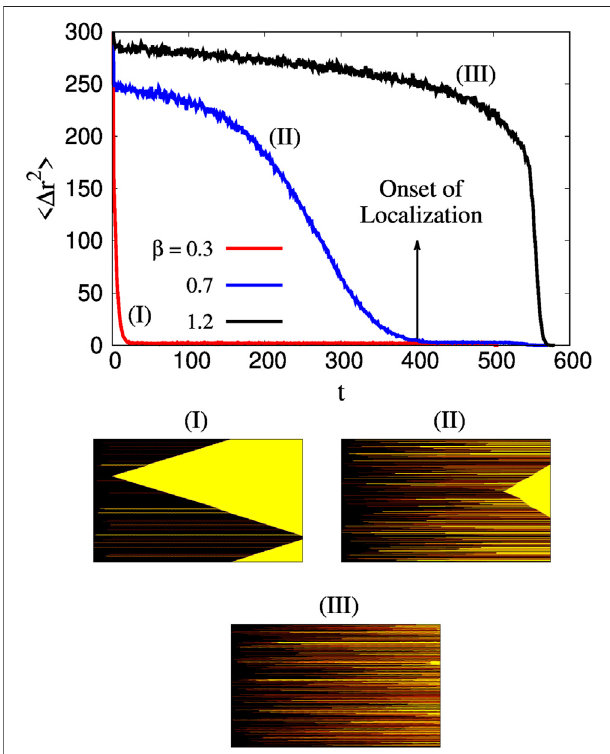
FIGURE 3 | Variation of 〈 Δ r 2 〉 with time t for three different disorder strengths β (cid:1) 0.3, 0.7 and 1.2. 〈 Δ r 2 〉 is average square distance between consecutive rupture events. 〈 Δ r 2 〉 starts from a high value and decreases to1 with time suggesting pure nucleation beyond this point. The spatial correlation is shown explicitly for three different cases (1) nucleation (2) avalanche and (3) percolation.